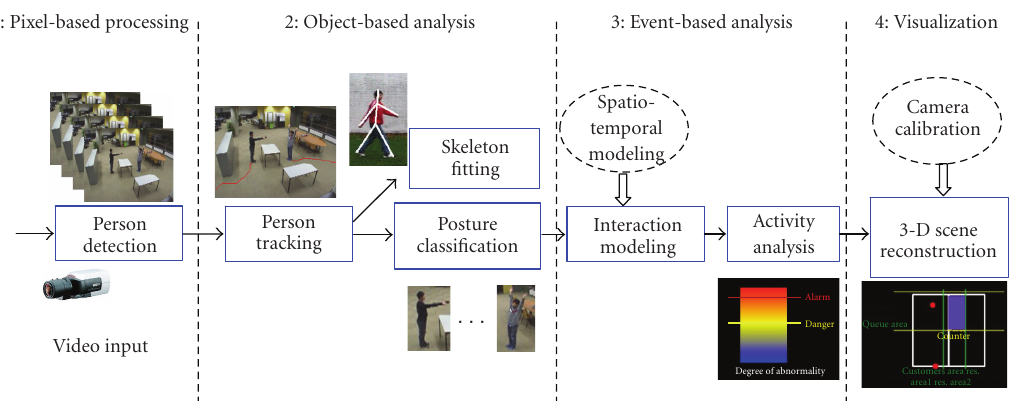
Figure 1: Block diagram of our four-level human motion analysis